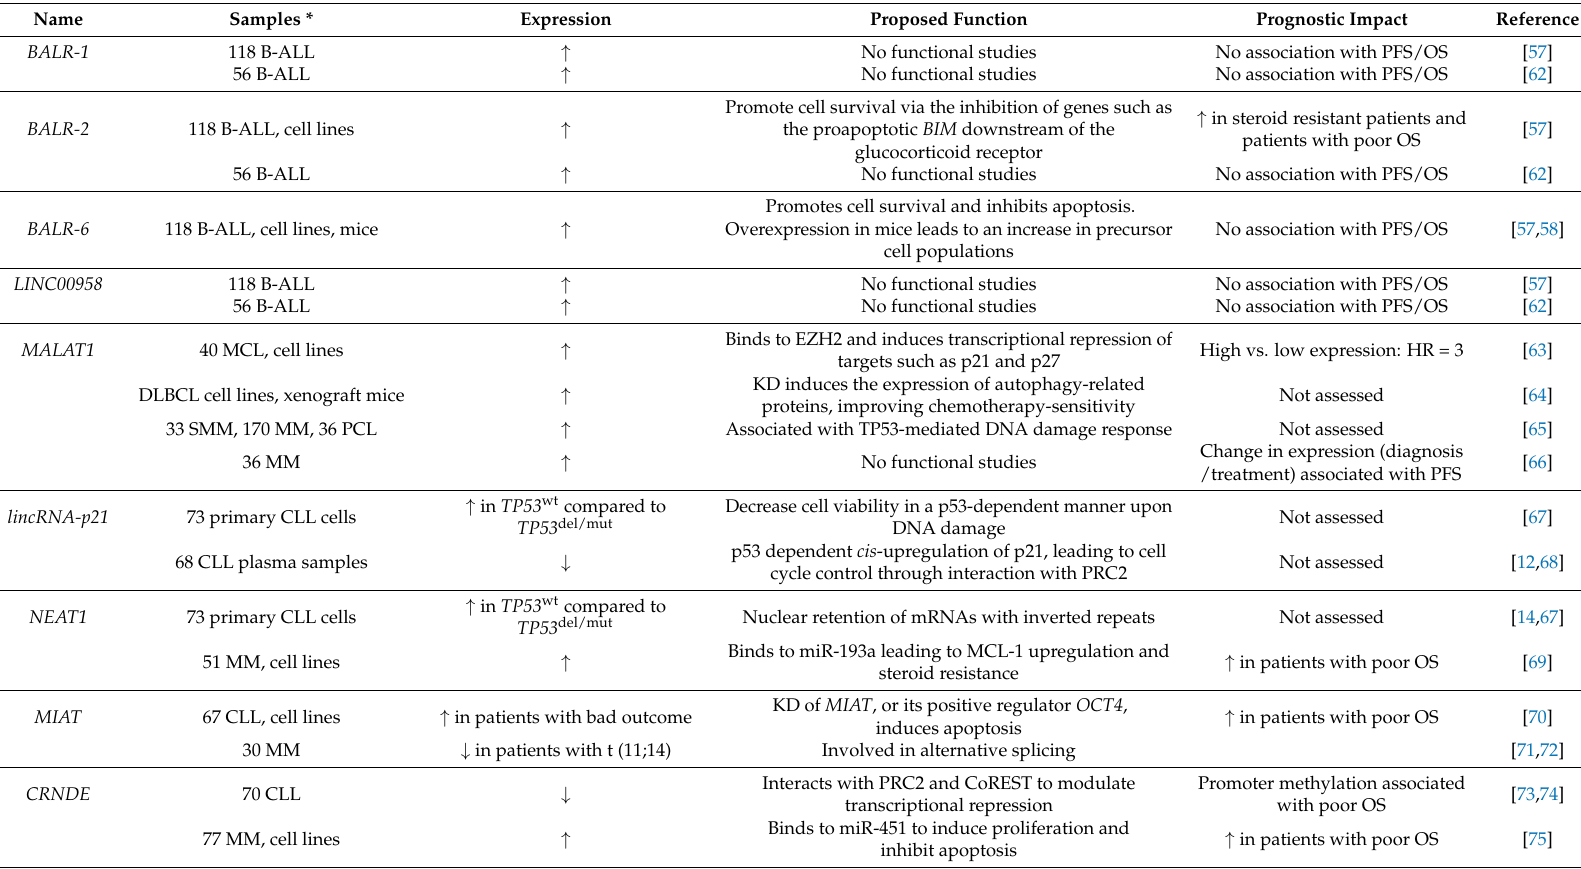
Table 1. LncRNAs with prognostic and/or functional impact in B-cell malignancies verified by more than one